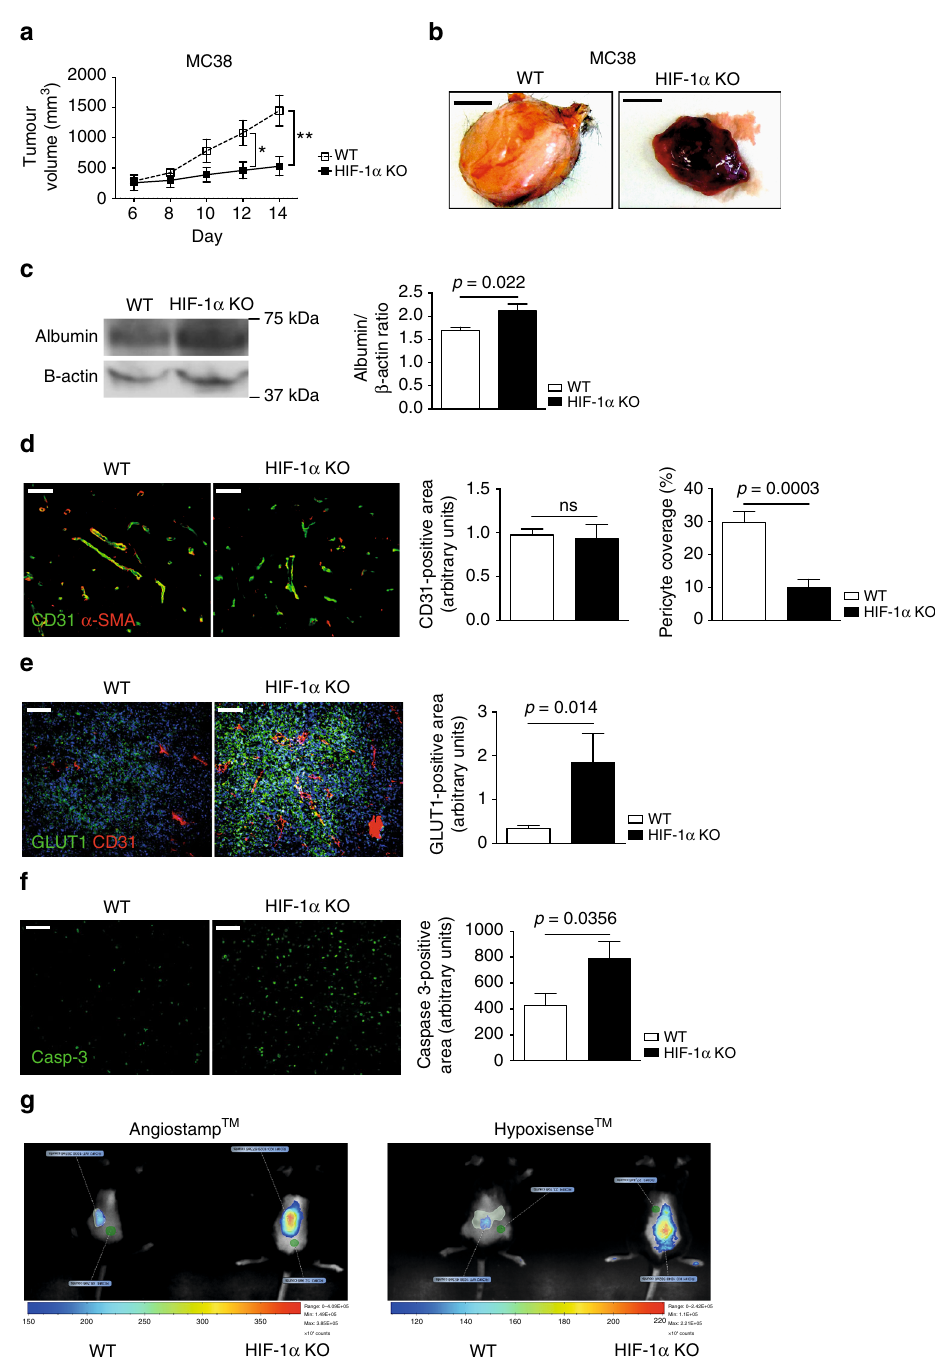
Fig. 2 Loss of HIF-1 α in NK cells impairs tumour growth and promotes non-functional angiogenesis. a Tumour volume analysis of MC38 isografts injected subcutaneously in WT and HIF-1 α KO mice ( n = 10 for each group), b and representative images at endpoint, day 14. Scale bars in macroscopic fi gures indicate 5 mm. c Left: Western blot of albumin and β -actin for MC38 tumours from WT and HIF-1 α KO mice; Right: Quantitative analysis of intratumoural amounts of albumin for MC38 isografts from WT and HIF-1 α KO mice ( n = 8). d Left: representative images of simultaneous immunodetection of endothelial cells and pericytes in MC38 tumours with the speci fi c markers CD31 and alpha smooth muscle actin ( α -SMA); Right: Quantitative analysis of CD31-positive endothelial cells in WT and HIF-1 α KO mice ( n = 8) and pericyte coverage as assessed by α -SMA/CD31 co-localisation ( n = 8). e Left: representative images of tumour hypoxia in MC38 isografts with the speci fi c markers CD31 and GLUT1; Right: Quantitative analysis of hypoxic tumour areas ( n = 8). f Left: representative images of caspase-3-positive area in MC38 tumours; Right: Quantitative analysis of caspase-3-positive areas ( n = 10). g Representative images of non-invasive fl uorescence molecular real-time imaging with the fl uorescent probes AngioSense ® and HypoxiSense ® for in vivo monitoring of angiogenesis and tumour oxygenation at day 8 after tumour inocculation. Statistical signi fi cance was determined by an unpaired Student ’ s t -test or one-way analysis of variance, where appropriate. Bars represent mean values; error bars indicate the s.e.m. Statistical signi fi cance is indicated as * P < 0.05, ** P < 0.01, and *** P < 0.001. Scale bar, 100 μ